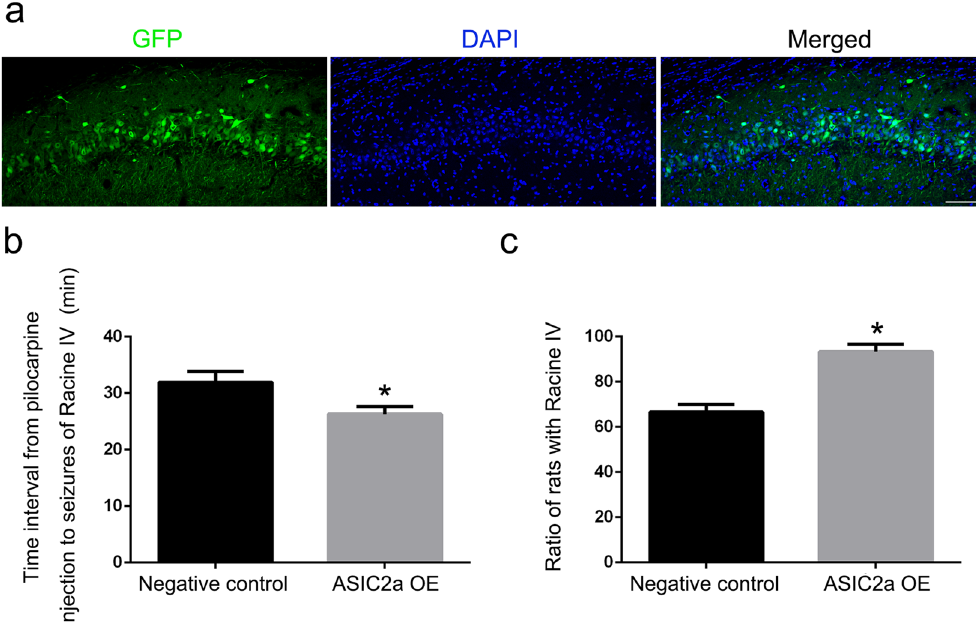
Figure 7. Hippocampal ASIC2a overexpression increased seizure susceptibility. ( a ) Representative images showing GFP immunoreactivity in the hippocampal CA1 region following adeno-associated virus (AAV) vector infusion. Scale bar = 100 μ m. ( b ) The time interval from pilocarpine injection to Racine IV seizures was significantly shorter in the ASIC2a overexpression group (26.3 ± 1.3 min) than in the negative control AAV group (31.9 ± 1.9) (n = 30 rats/group). ( c ) The proportion of rats with Racine IV seizures after pilocarpine treatment was significantly higher in the ASIC2a overexpression group (93.3 ± 3.33%) than in the negative control AAV group (66.7 ± 3.33%). Data are presented as means ± standard errors and were analysed using unpaired t-tests or Chi-square tests. * P < 0.05 compared with negative control group. Abbreviations, ASIC2a: acid-sensing ion channel 2a; GFP: green fluorescent protein; DAPI: 4 ′ , 6-diamidino-2-phenylindole; OE: